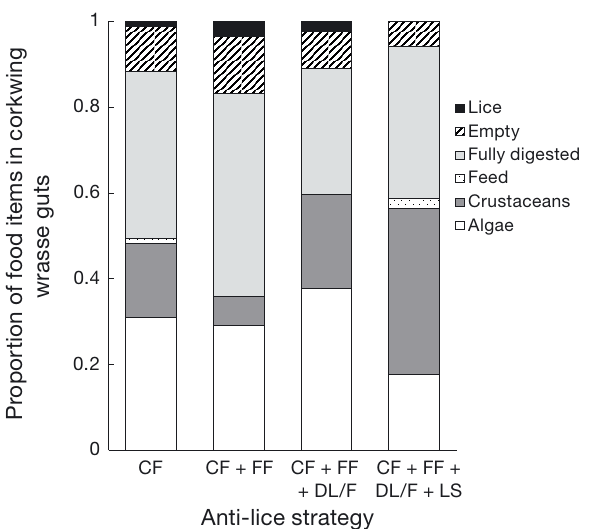
Fig. 8. Proportion of corkwing wrasse with primarily algae, crustacea, feed, lice, fully digested/unidentifiable content or nothing in their gut for different lice prevention strategies. See Fig. 1 for